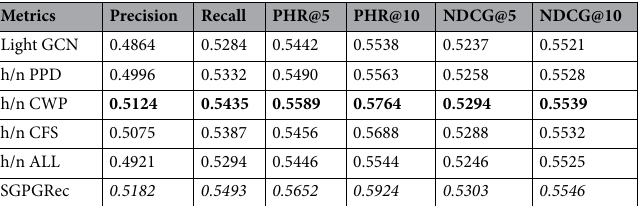
Table 3. Comparison of the impact on recommendation performance for different tasks. The best results in ablation experiments are in bold, and the results of complete method are in italic.